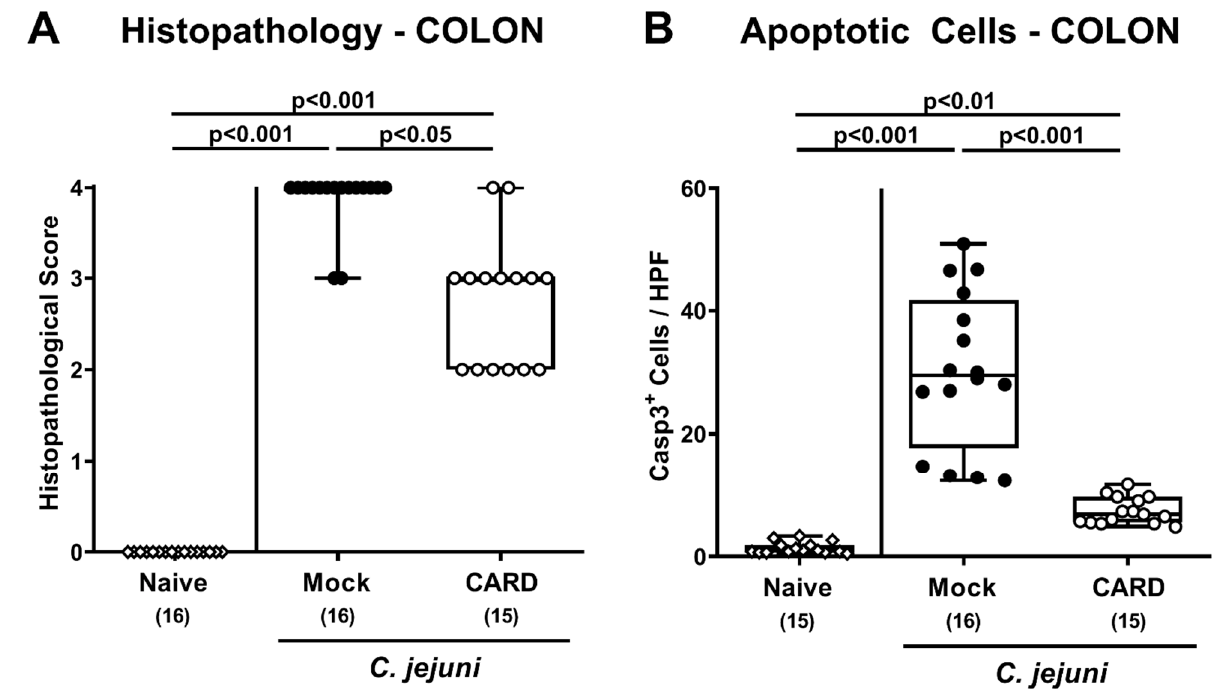
Figure 4. Histopathological and apoptotic responses in the large intestines following oral cardamom essential oil application to C. jejuni -infected microbiota-depleted IL-10 − / − mice. Microbiota-depleted IL-10 − / − mice were infected with C. jejuni strain 81–176 on days 0 and 1 by gavage and perorally challenged with cardamom essential oil (CARD; white circles) via the drinking water starting on day 2 post-infection, whereas mock control mice received vehicle (black circles). On day 6 post-infection, the ( A ) histopathological changes were quantitatively assessed in hematoxylin and eosin stained colonic paraffin sections, using a respective scoring system. In addition, ( B ) apoptotic colonic epithelial cells positive for cleaved caspase3 (Casp3 + ) were enumerated in immunohistochemically stained large intestinal paraffin sections (indicated are the median numbers of positively stained cells from six high power fields (HPF, 400 × magnification) per animal). Naive mice (open diamonds) served as untreated and uninfected controls. The box plots indicating the 75th and the 25th percentiles of the median (black bar within box), the total range, the levels of significance ( p values) as calculated with the Kruskal–Wallis test and Dunn’s post-correction, and the number of analyzed mice (in parentheses) are shown. Data were pooled from four independent experiments.